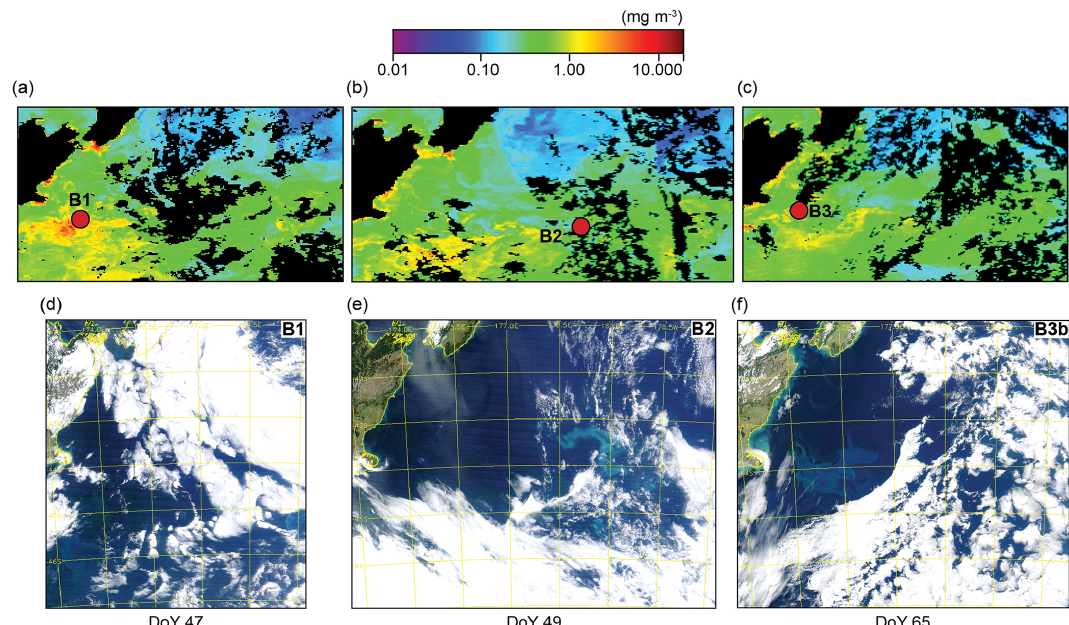
Figure 4. Eight-day composite images of surface chlorophyll a (MODIS, 4km resolution) during the SOAP voyage for (a) 10–17 Febru- ary 2012 (DoY 41–48), (b) 18–25 February 2012 (DoY 49–56) and (c) 26 February–4 March (DoY 57–64), showing bloom locations (red dots), with the color scale (mgm − 3 ) above figures (a–c) , and daily true-color images for (d) Bloom 1 (16 February 2012, DoY 47), (e) Bloom 2 (18 February 2012, DoY 49) and (f) Bloom 3 (3 March, DoY 65) (MODIS Aqua data courtesy of